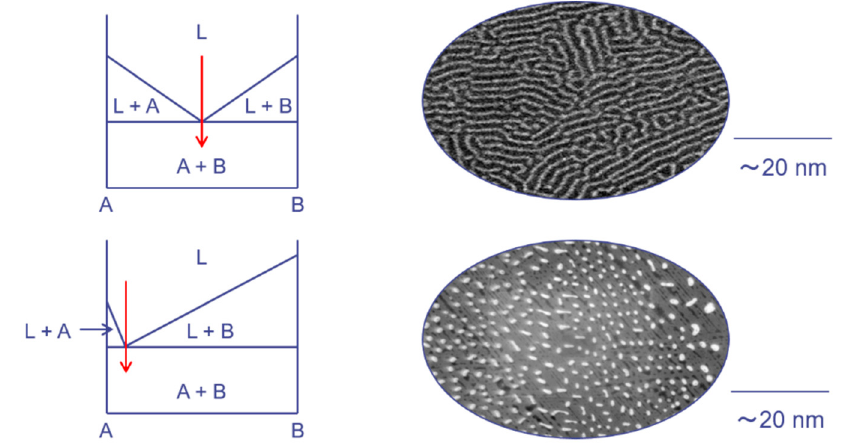
Figure 3. Relationship between phase diagram and nanostructure. According to the position of the eutectic point, nano-lamellar or nano-dot structure can be obtained by melt-spinning (MS).